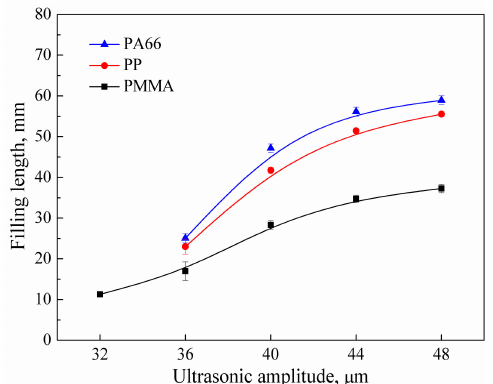
Figure 2. Influence of ultrasonic amplitude on the filling length of polymer melt (UT = 6 s, PPe = 14 MPa, HT = 6 s, HP = 14 MPa, MT = 60 ◦ C; Mold